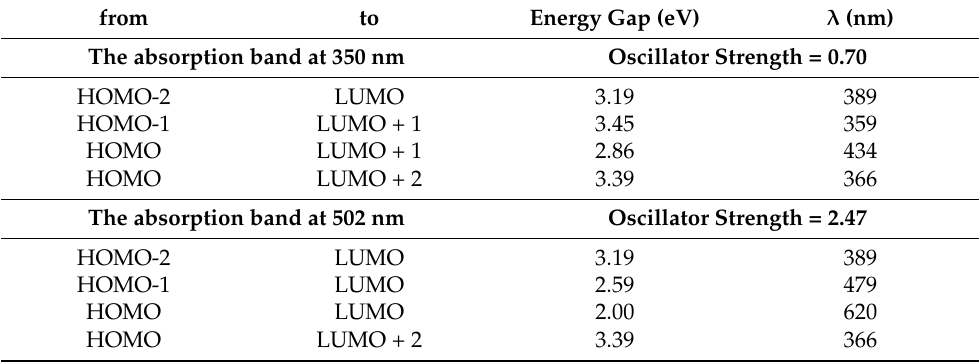
Table 5. Absorption transitions for each absorption band. from to Energy Gap (eV) λ (nm) The absorption band at 350 nm Oscillator Strength = 0.70 HOMO-2 LUMO 3.19 389 HOMO-1 LUMO + 1 3.45 359 HOMO LUMO + 1 2.86 434 HOMO LUMO + 2 3.39 366 The absorption band at 502 nm Oscillator Strength = 2.47 HOMO-2 LUMO 3.19 389 HOMO-1 LUMO 2.59 479 HOMO LUMO 2.00 620 HOMO LUMO + 2 3.39 366